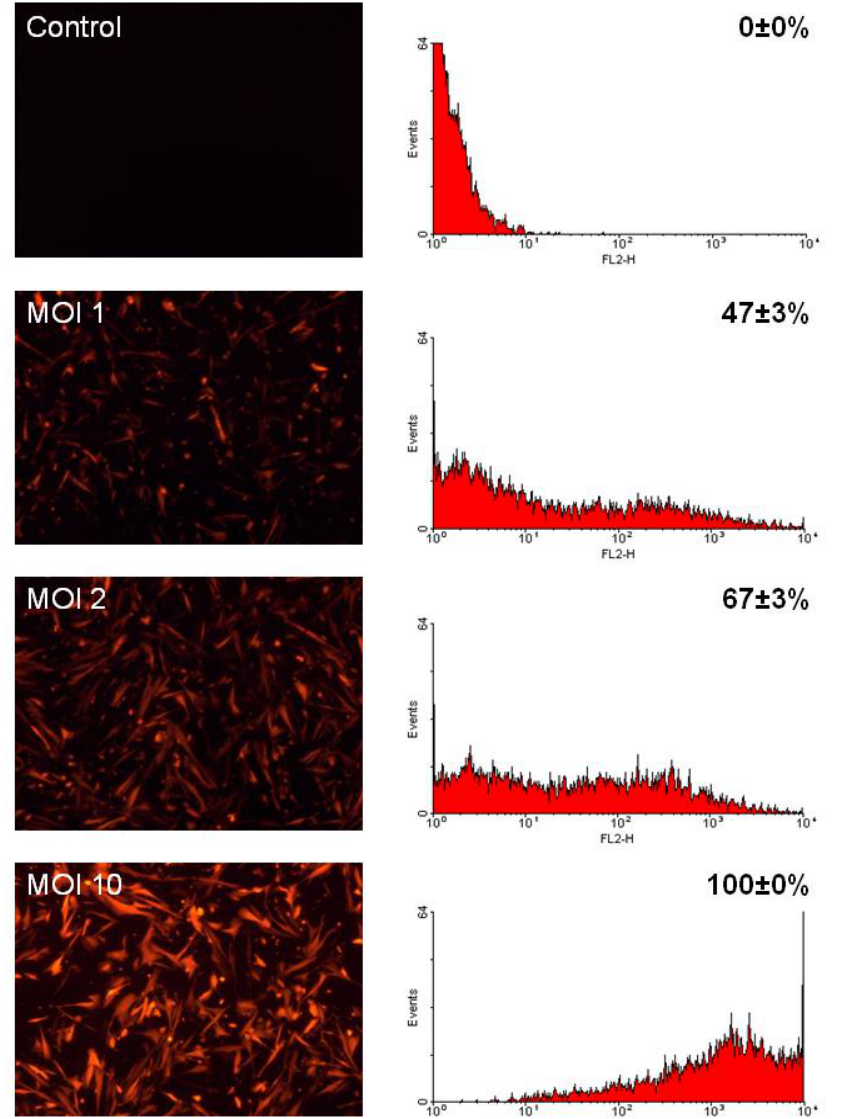
Figure 1. Efficient transduction of cardiomyocyte progenitor cells (CMPCs) with lentivirus (LV) vectors. CMPCs were transduced with LV-DsRed at multiplicities of infection (MOIs) of 1, 2, and 10. Four days after transduction, cells were assessed by fluorescence microscopy (left) and flow cytometry (right). Histogram plots demonstrate that the proportion of DsRed-positive cells increases as a function of the MOI. Transduction efficiency is presented as mean ± standard error of the mean (SEM) (n =